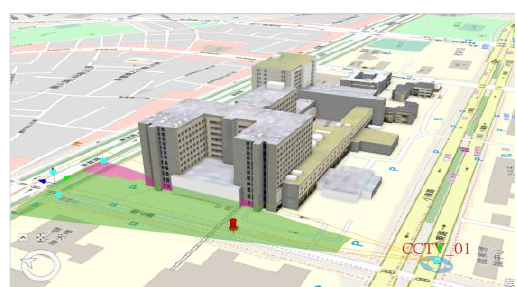
Figure 16 The FOV of CCTV01